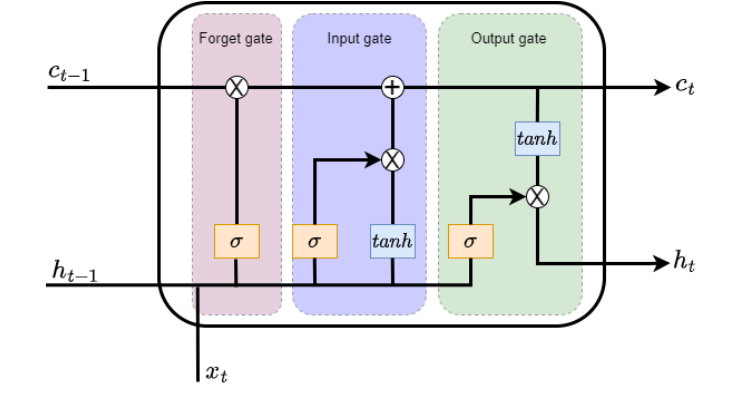
Figure 4. A representation of the LSTM